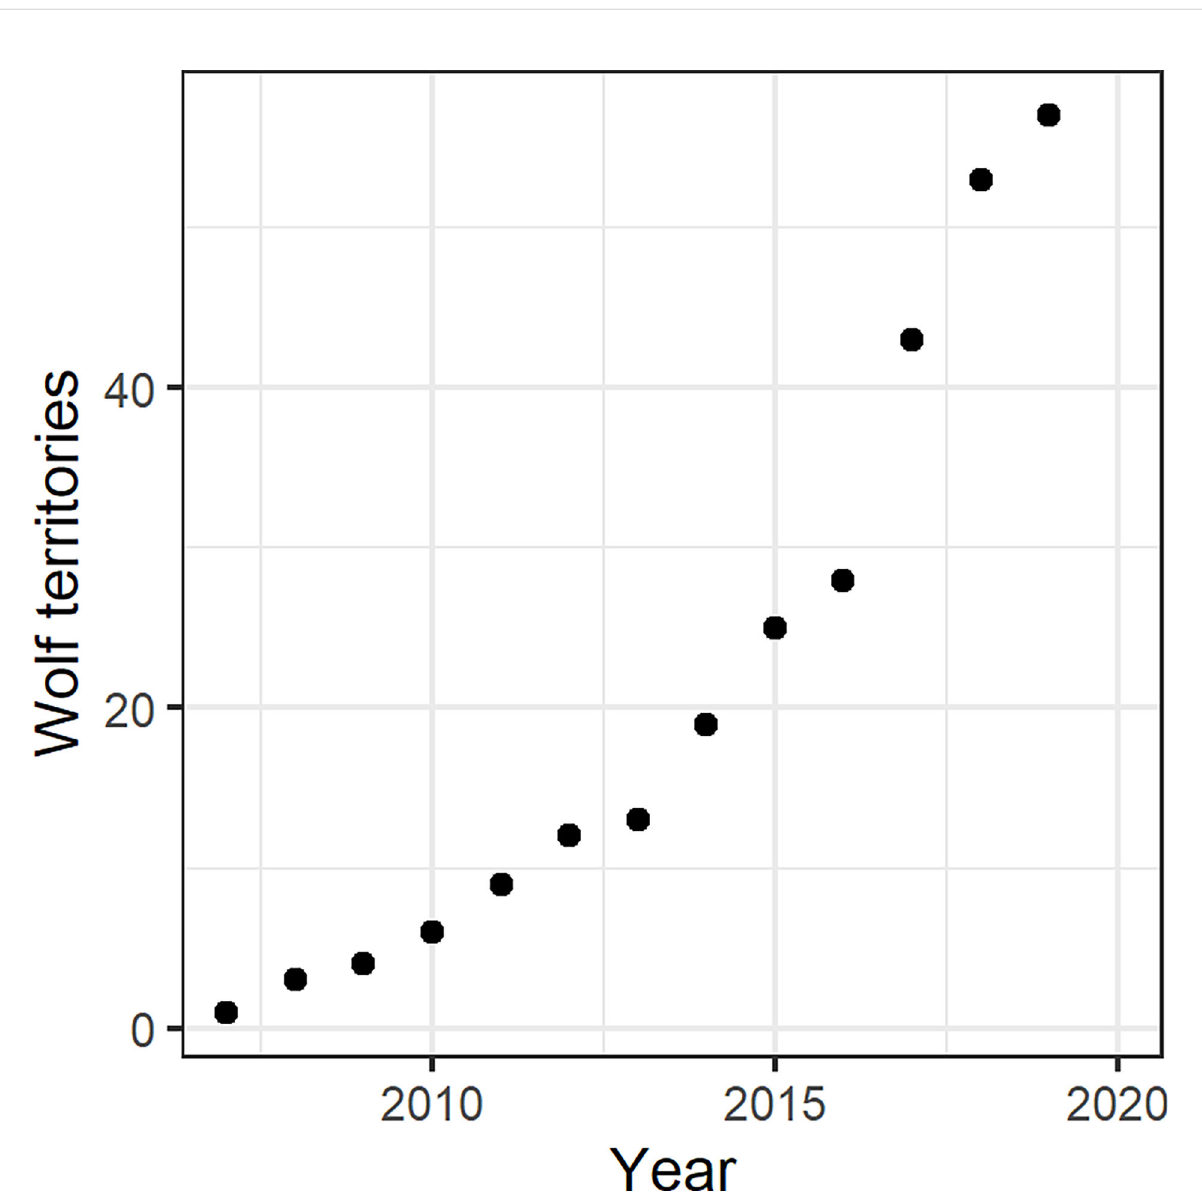
FIGURE 1 Number of wolf territories (sum of wolf packs, wolf pairs and territorial wolves) in Brandenburg State (Germany) from 2007/2008 to 2019/2020. The years are based on the wolf monitoring calendar (May 1 through April 30 of the following